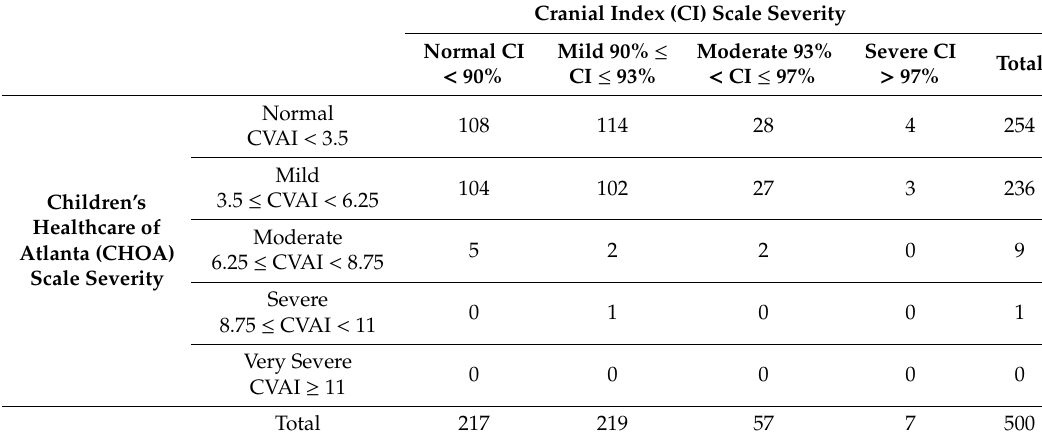
Table 2. Number of infants within each cranial severity category at the end of treatment based on the initial cranial vault asymmetry index (CVAI) and cephalic index (CI).